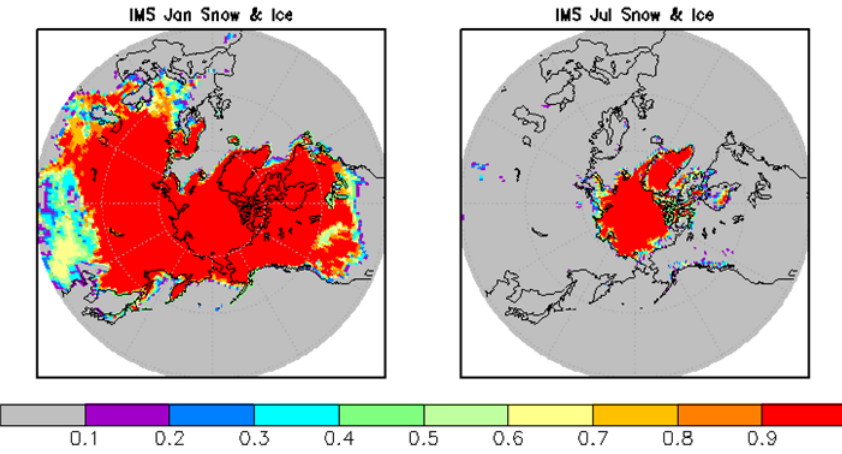
Figure 11. Northern Hemisphere combined monthly fraction of snow and sea-ice from the IMS analysis averaged to a 1° spatial grid for January 2008 (left) and July 2008 (right).